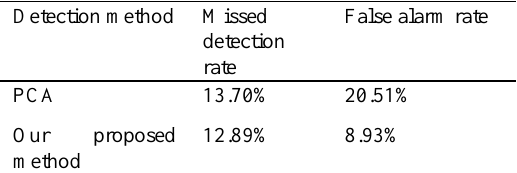
Table 2. Comparison of the detection performance of the proposed method and that of